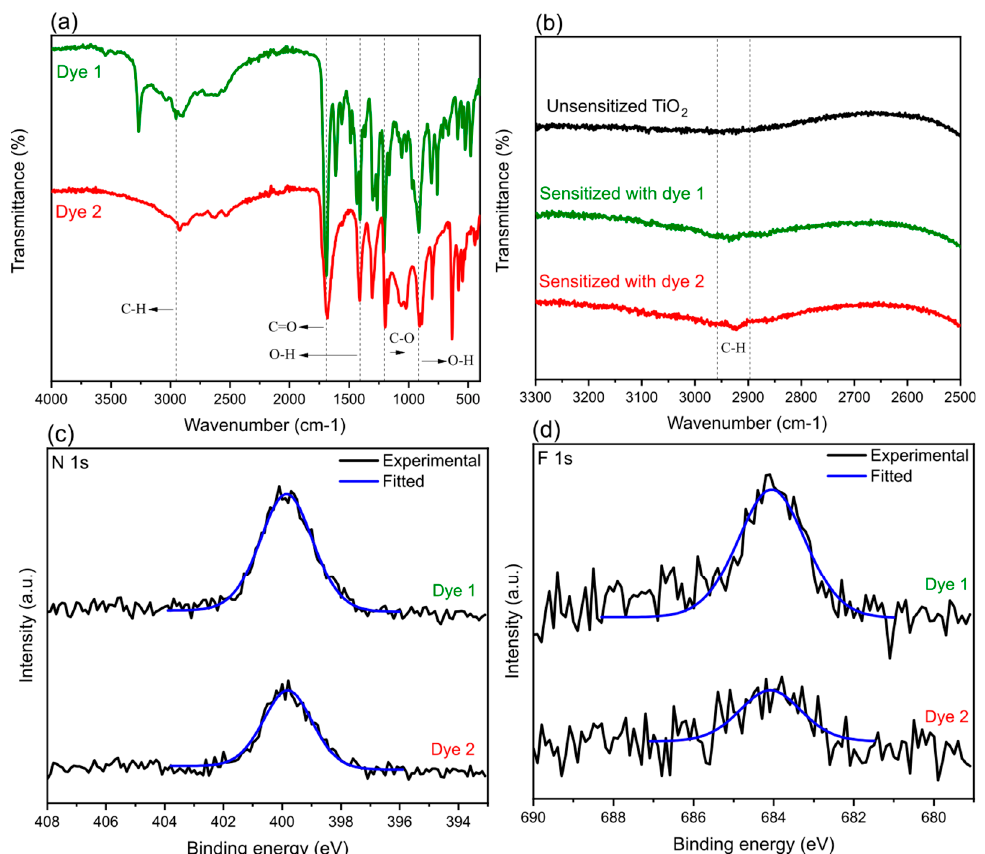
Figure 2. Fourier-transform infrared (FTIR) spectra of bodipy ( a ) dye 1 (green curve) and dye 2 (red curve) in a powder form along with the inset ( b ) of untreated (black curve) and sensitized TiO 2 photoelectrodes on glass substrate. The whole range for the FTIR spectra of TiO 2 photoelectrodes can be seen in Supplementary Materials Figure S5. The high-resolution ( c ) N 1s and ( d ) F 1s